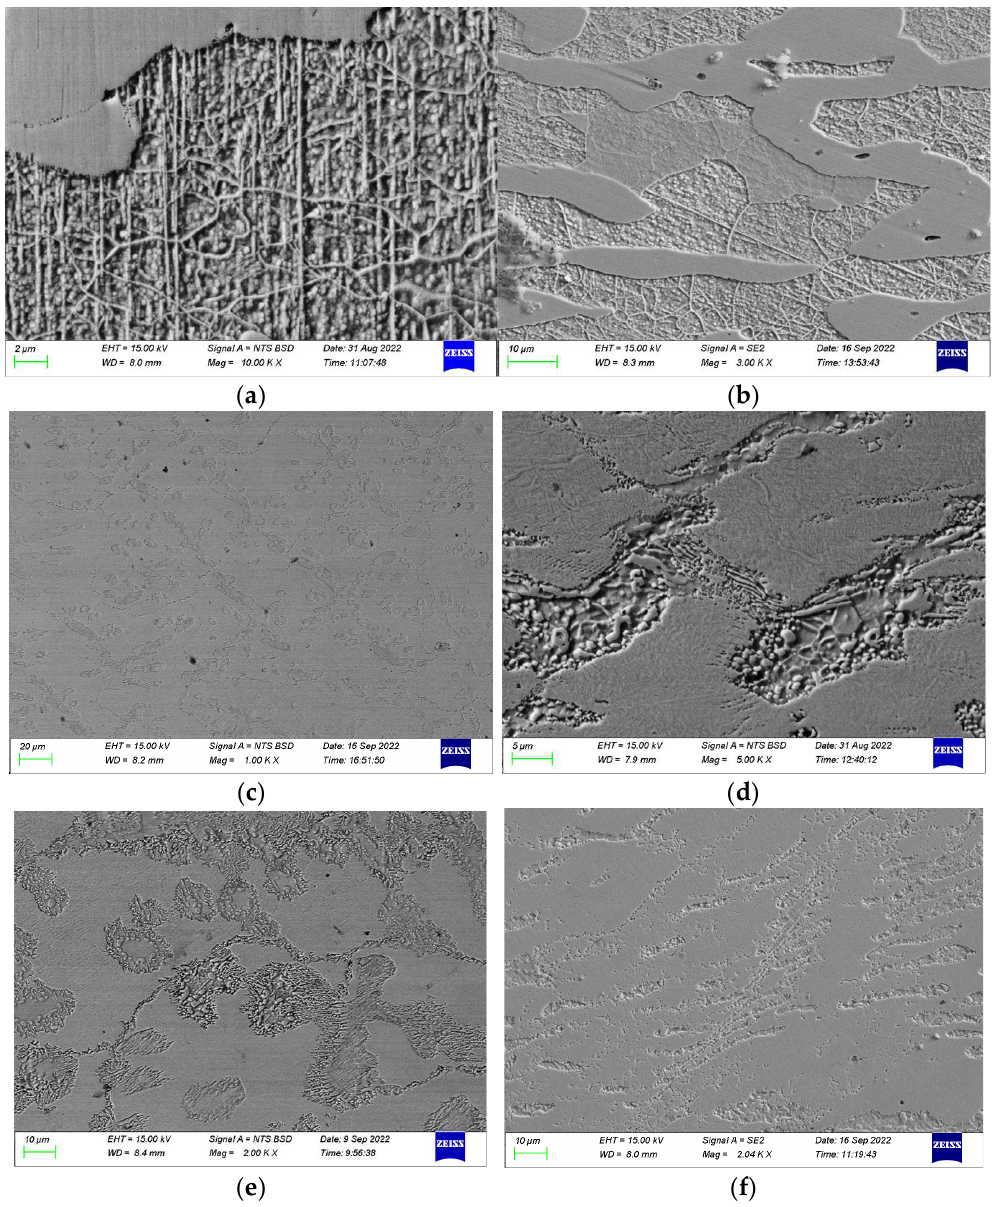
Figure 12. Higher-magnification-scanning electron images of deformed Fe-30.9Mn-4.9Al-4.5Cr-0.4C at ( a ) 800 °C at 0.1 s −1 ; ( b ) 1000 °C at 5 s −1 ; ( c ) 1000 °C at 0.1 s −1 and Fe-21.3Mn-7.6Al-4.3Cr-1C at ( d ) at ( a ) 800 ◦ C at 0.1 s − 1 ; ( b ) 1000 ◦ C at 5 s − 1 ; ( c ) 1000 ◦ C at 0.1 s − 1 and Fe-21.3Mn-7.6Al-4.3Cr-1C at 800 °C at 5 s −1 ; ( e ) 900 °C at 0.1 s −1 ; ( f ) 1000° C at 5 s −1 . ( d ) 800 ◦ C at 5 s − 1 ; ( e ) 900 ◦ C at 0.1 s − 1 ; ( f ) 1000 ◦ C at 5 s − 1